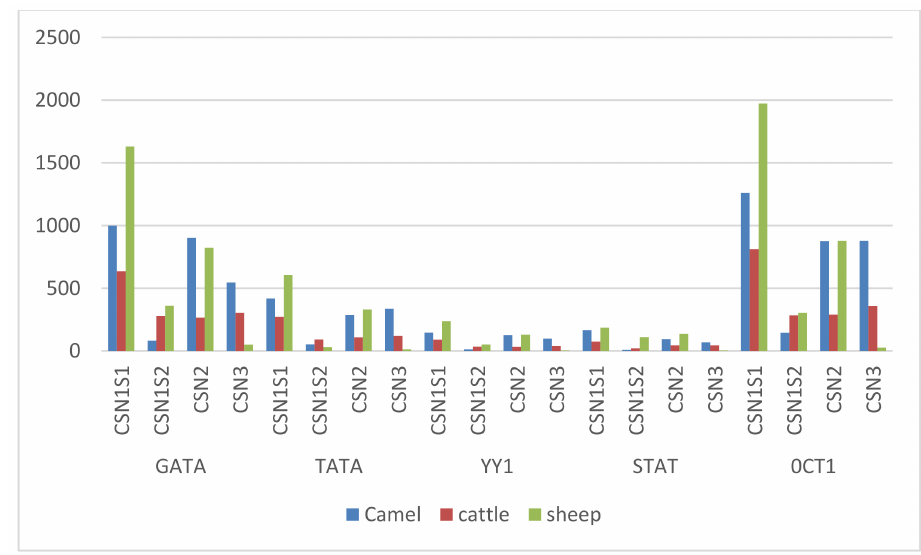
Figure 6. In the genomes of the casein protein, a comparison of the distribution of potential transcrip- tion binding sites in Camelus ferus , Bos Tarus , and Ovis Aries